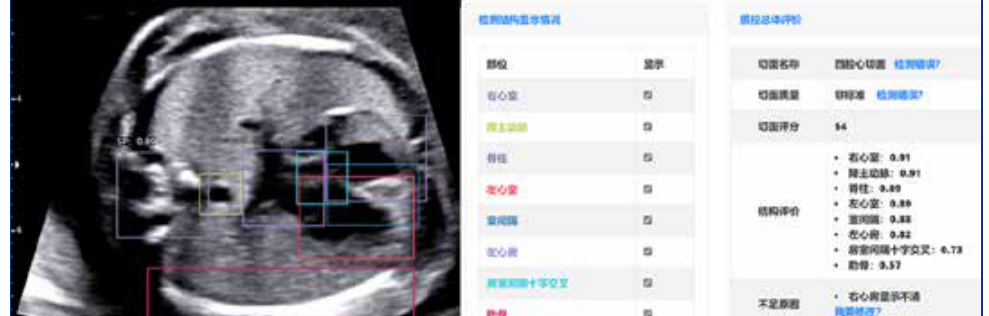
Figure 3 Intelligent image detection report showing non-standard section quality and insufficient